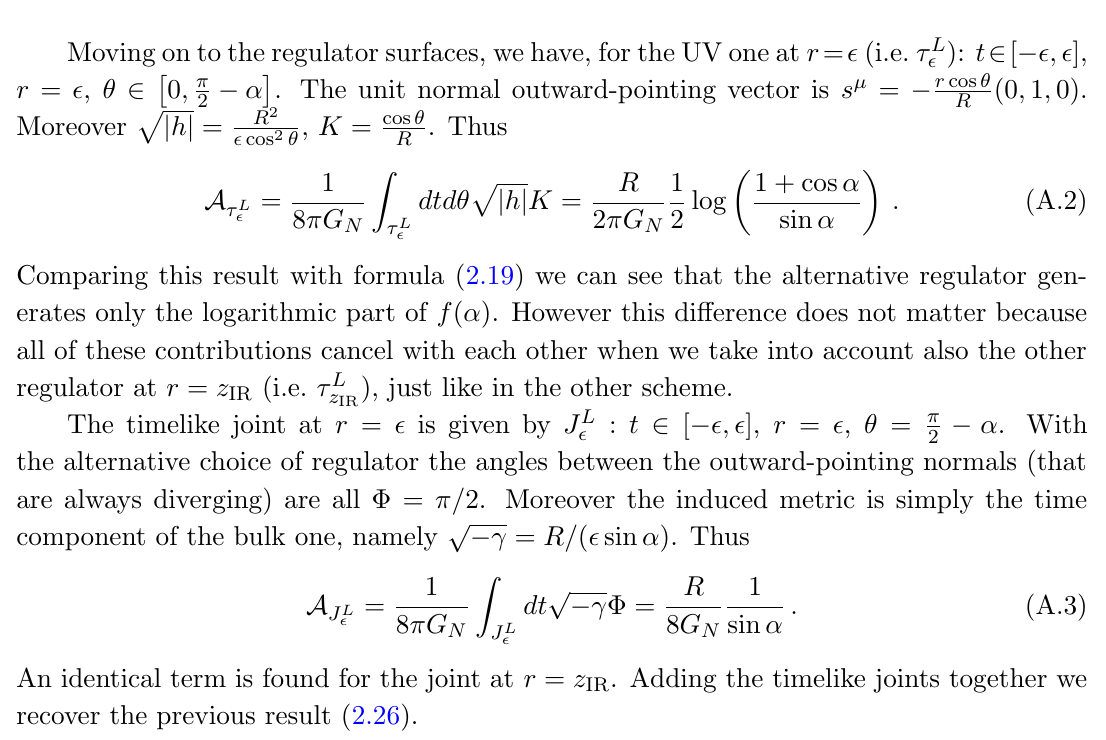
Figure 6 . The future half of the WDW patch in the alternative regularization